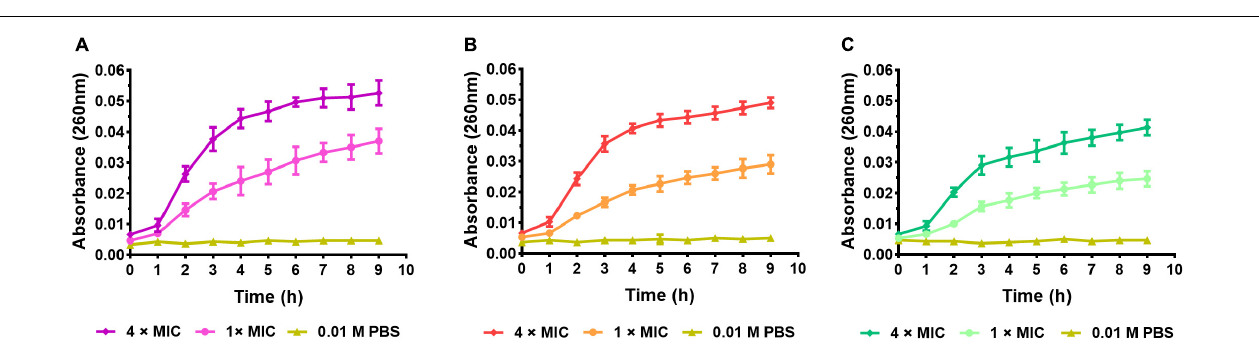
FIGURE 9 | DNA binding assay. Line 1 (M) was the Trans2K Plus II DNA marker; Lines 2, 9, and 16 (C–, negative control) were the genome DNA untreated with AMP; Lines 8, 15, and 22 (C+, positive control) were the genome DNA treated with Penetratin; Lines 3–7, 10–14, and 17–21 were the DNA of E. coli (CMCC44103), E. coli (SYPB-3820), and S. aureus (CMCC26003) treated with S1, S2, and S3, respectively, under a concentration gradient of 1, 2, 4, 8, and 16 µ g/ml.